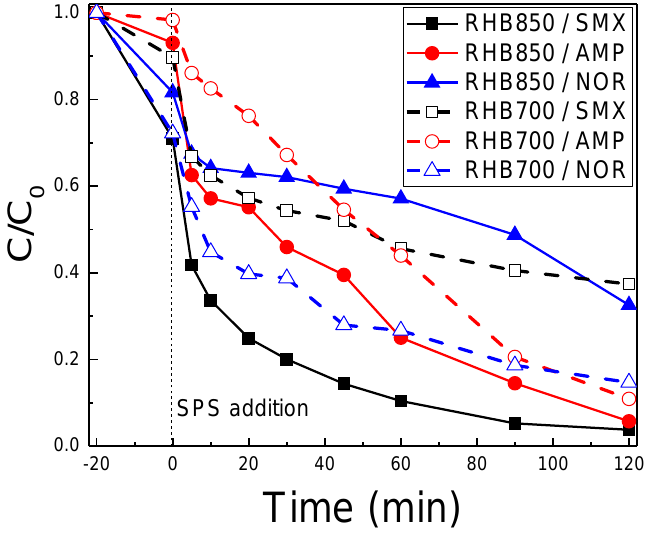
Figure 11. Degradation of various 500 mg L − 1 antibiotics with 100 mg L − 1 RHB850 or 500 mgL − 1 RHB700 and 500 mg L − 1 SPS in UPW and inherent pH.